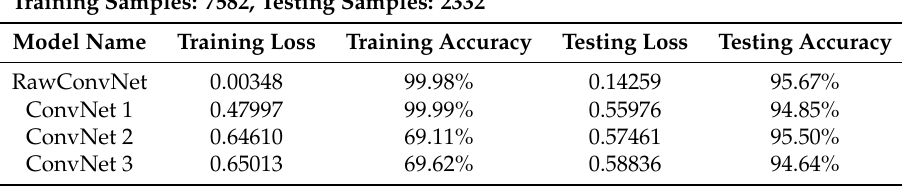
Table 14. Raw audio ConvNets on BUZZ2 train/test dataset.